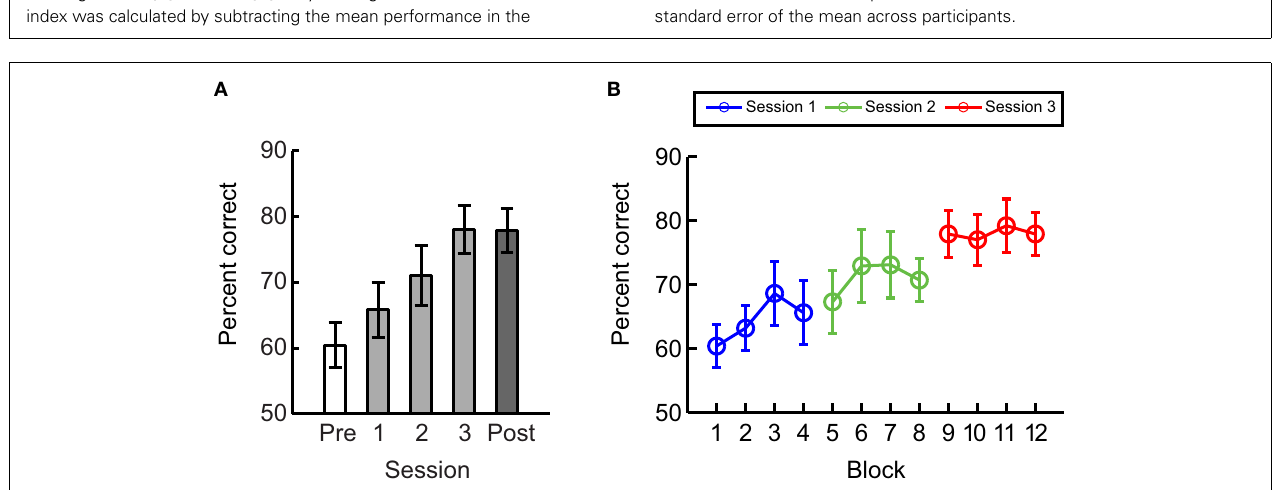
first test block from the last test block in a session.The between-session index was calculated as the mean performance difference between the last test block in the preceding session and first test block in the subsequent session. Error bars indicate the standard error of the mean across participants.